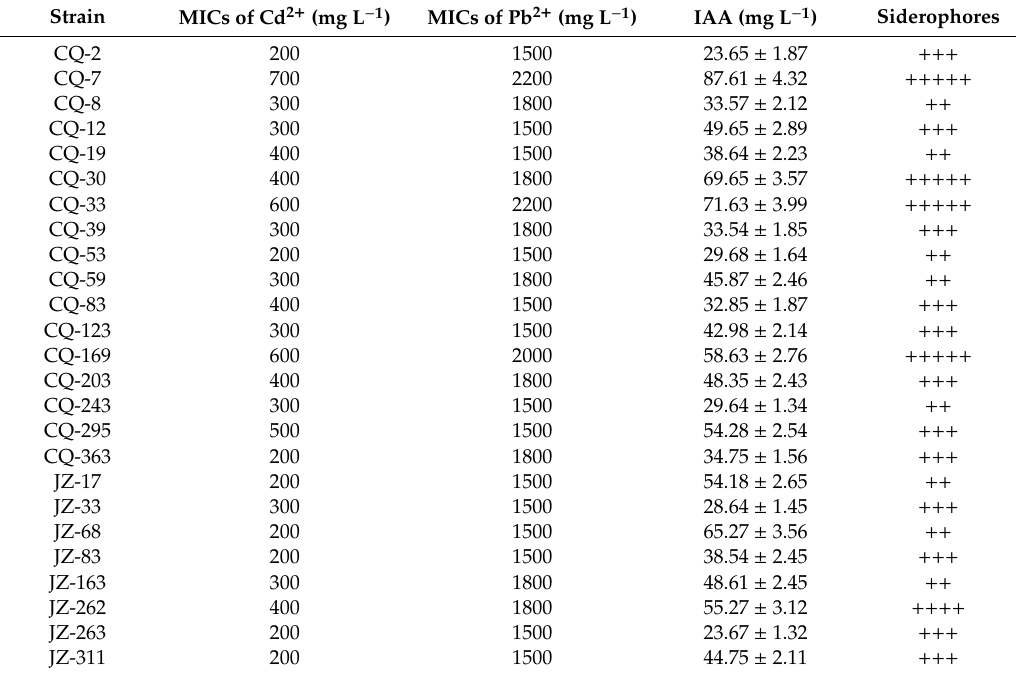
Table 2. Growthpromotioncharacteristicsandheavymetalresistanceofheavymetal-immobilizingbacteria.